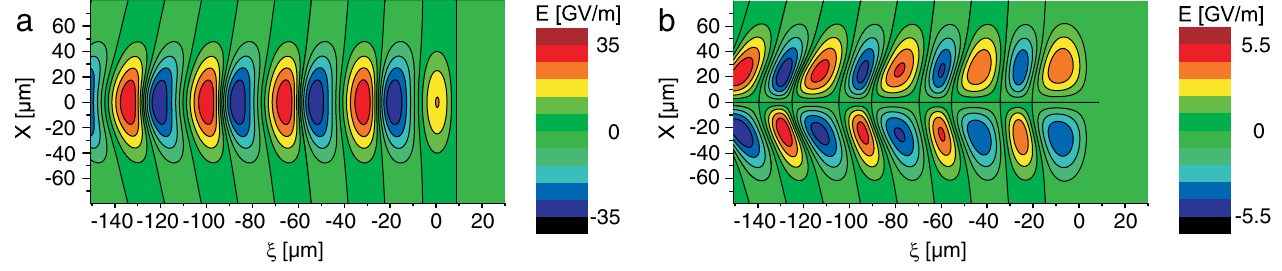
¼ 1 : 0 (cid:4) 10 24 m (cid:3) 3 e